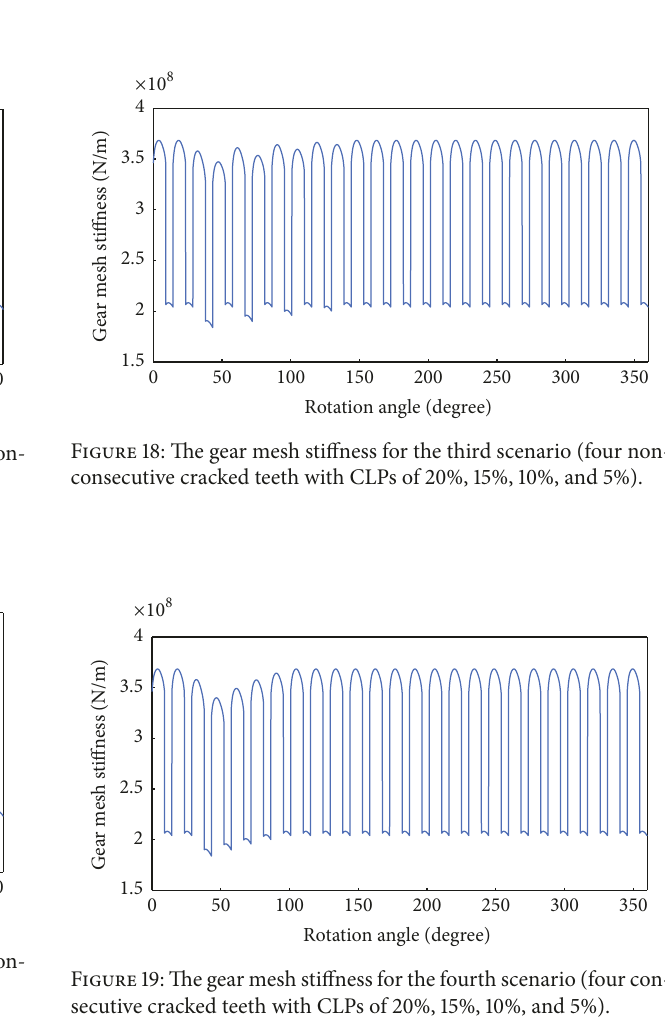
Figure 15: Multiple cracks scenarios. (a) Consecutive cracks and (b) nonconsecutive cracks.